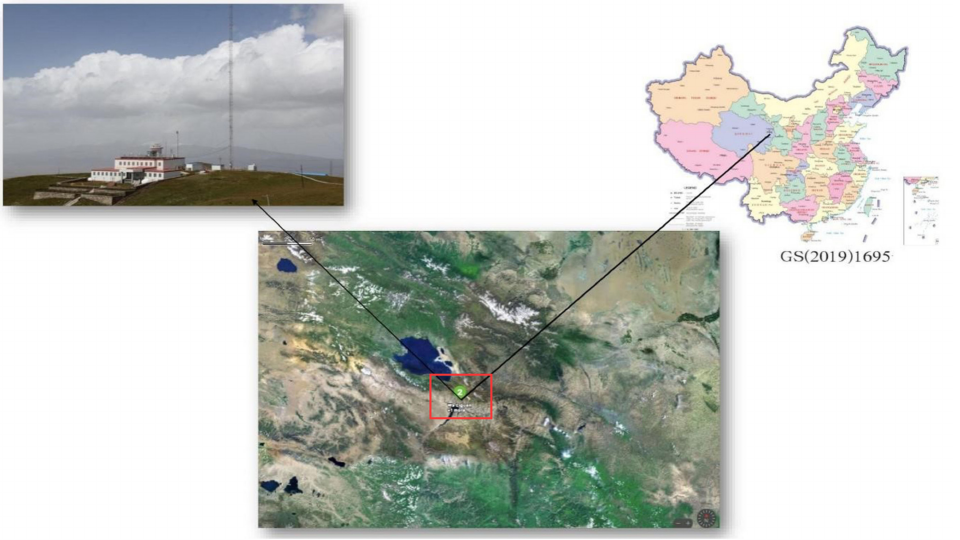
Figure 1. Site location of Mt. Waliguan. located in Waliguan Mountain in Gonghe County, Hainan Tibetan Autonomous Prefecture of Qinghai Province, China.